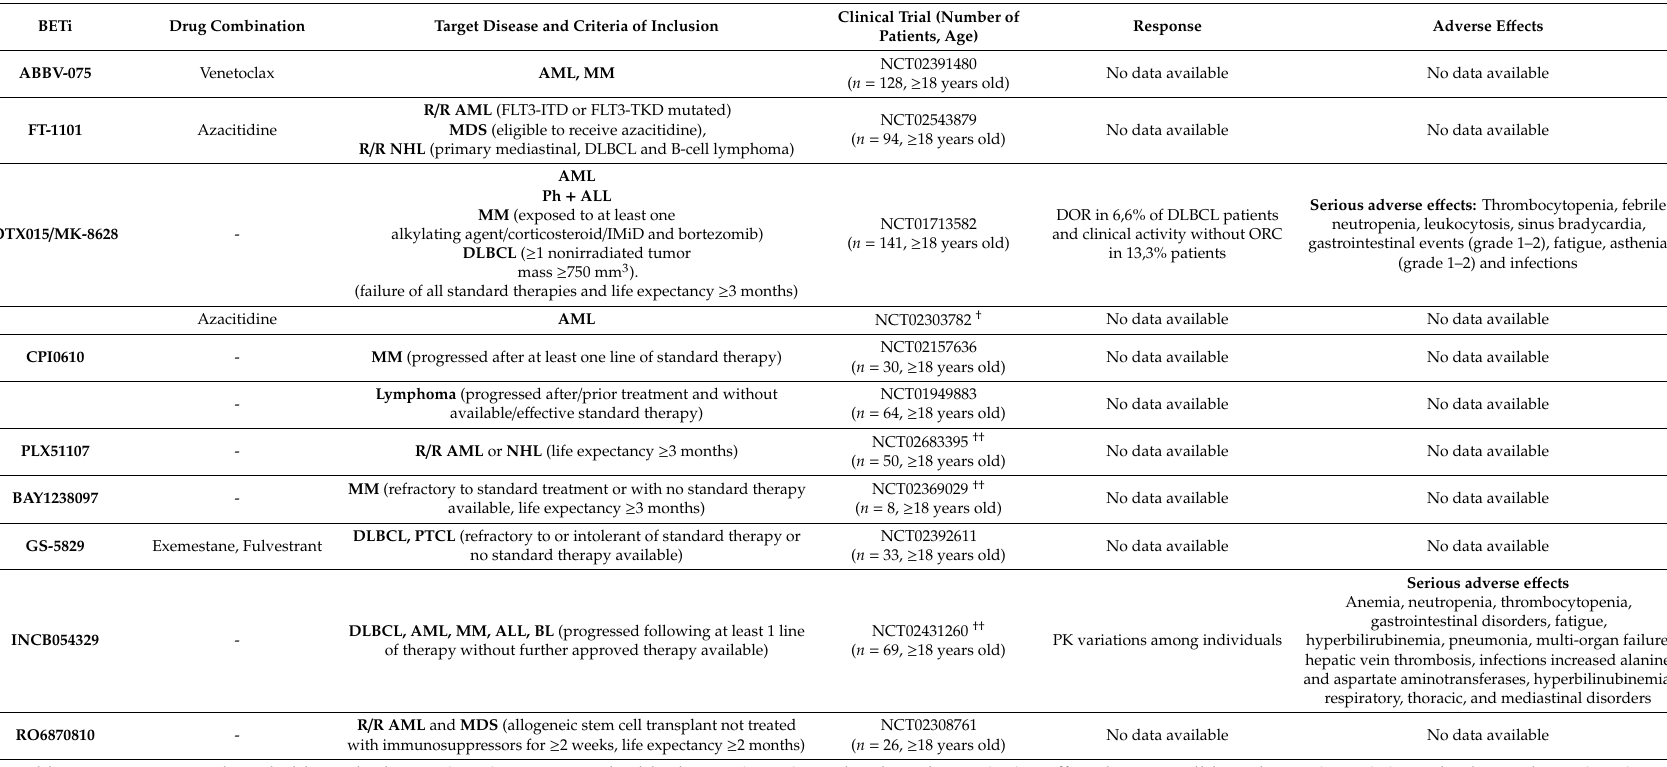
Table 2. E ffi cacy and toxicity of BET inhibitors in patients with hematological